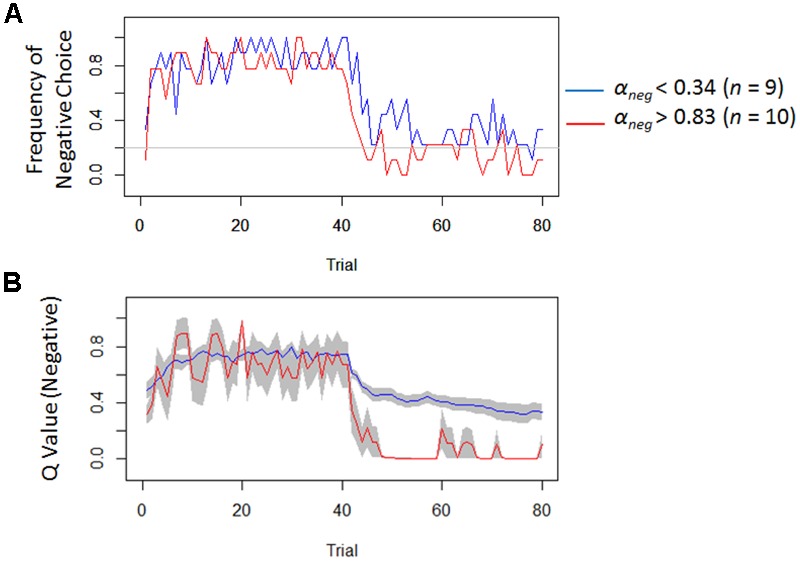
Frequency of negative choice and average outcome predictions of negative self-reference in Study 1. (A) Illustrates the average choice frequencies of negative self-reference for individuals from the upper (red) and lower quartiles (blue) of the learning rate of negative self-reference (i.e., αneg). (B) Shows the average outcome predictions of negative self-reference (Qneg) for the same individuals (standard errors are shown in the gray field).